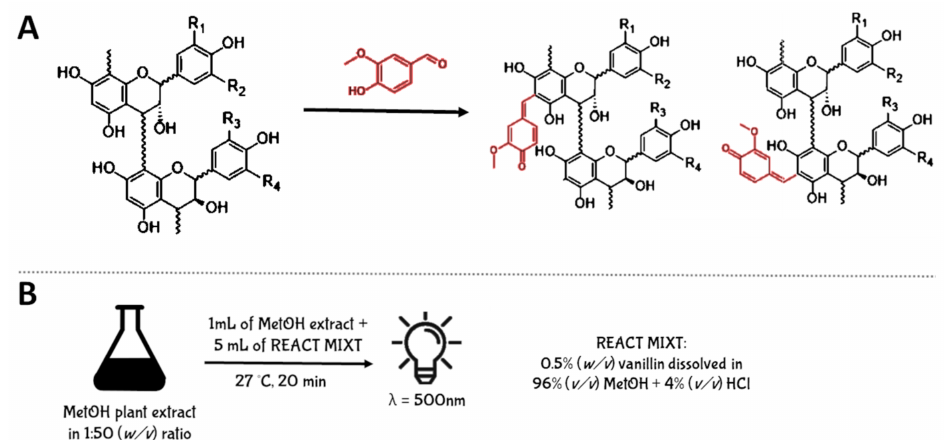
Figure 10. Schematic representation of Vanillin Assay for the quantification of PACs. Panel ( A ) dis- plays the chemical reaction that allows the formation of red colored adducts, spectrophotometrically measured at 500 nm. Panel ( B ) displays the experimental